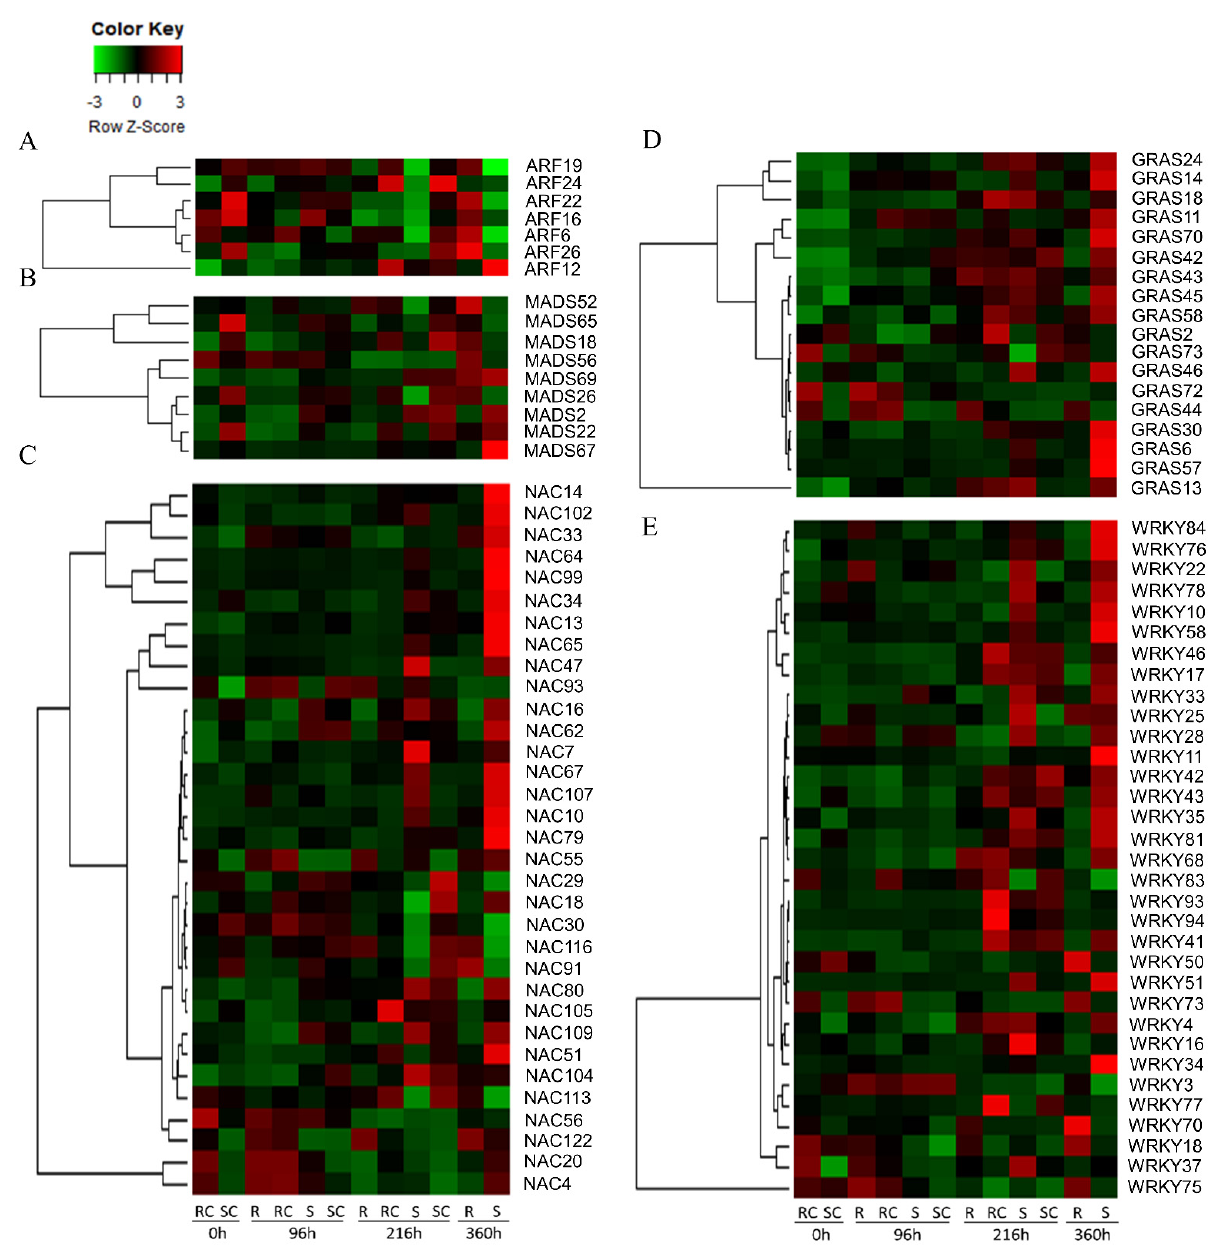
Figure 6. ( A – E ) Expression dynamics of transcription factors (TFs) in sugarcane aphid resistant and susceptible sorghum genotypes at different time points post-infestation. Different TF family members show dynamic expression profiles across genotypes and time points.